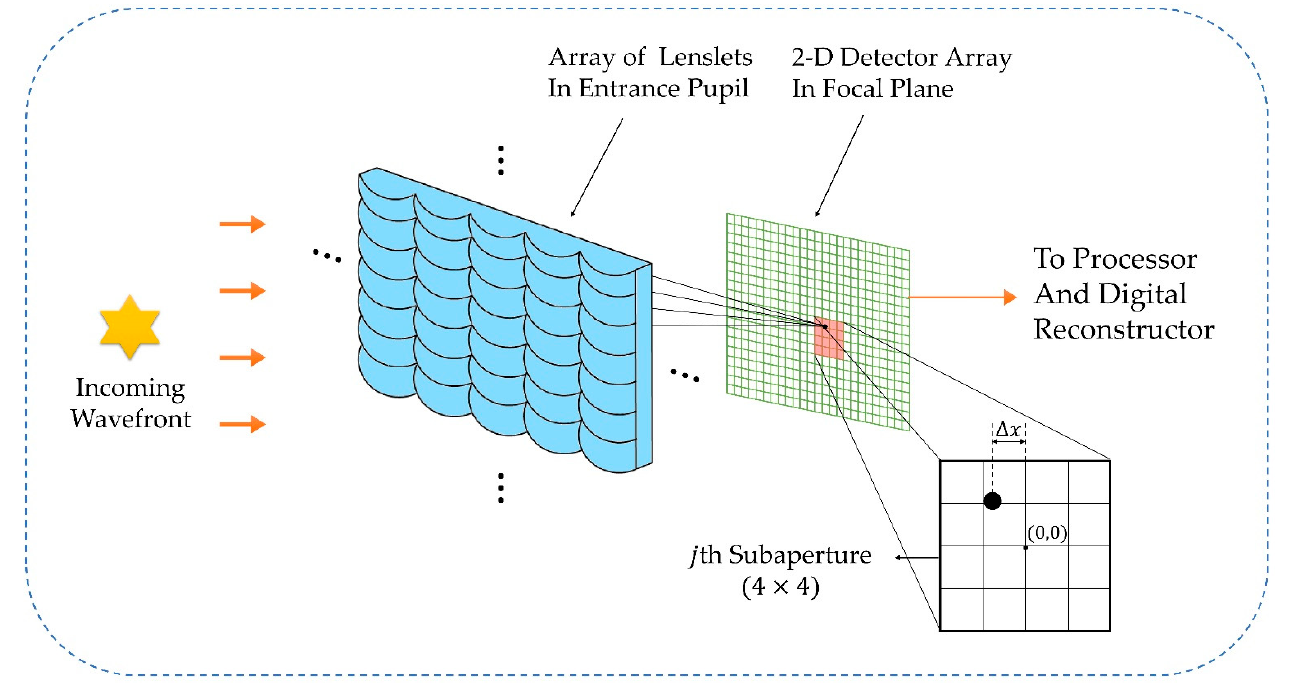
Figure 1. Schematic diagram of the SHWFS principle.